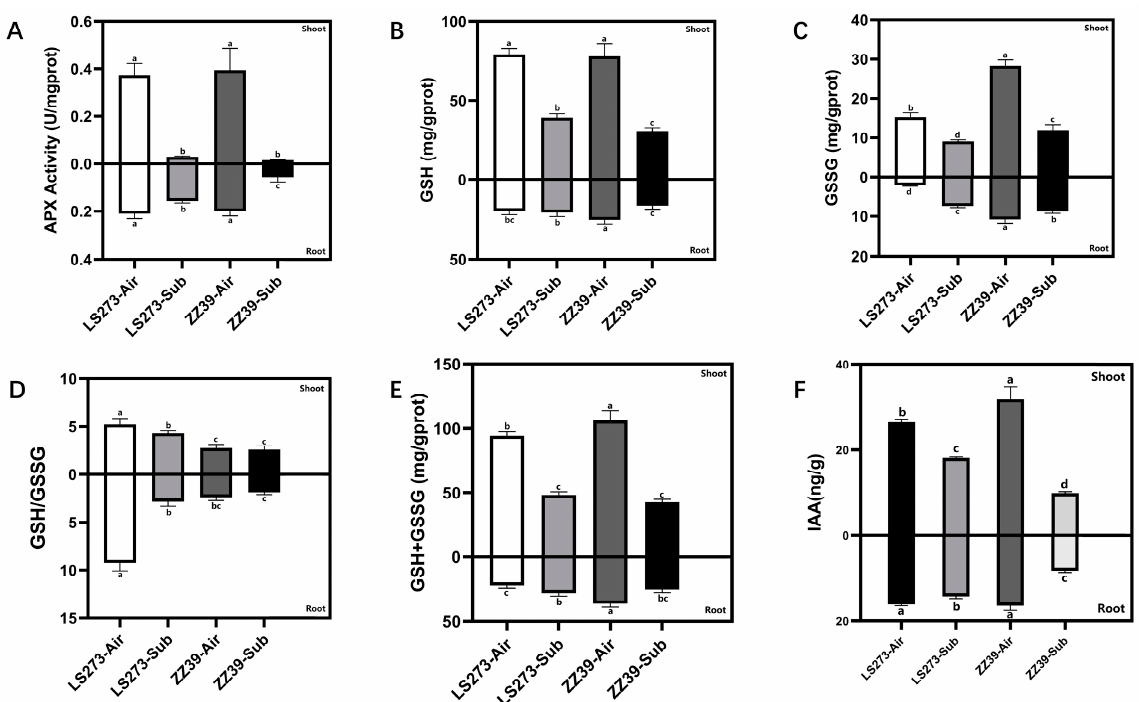
Figure 3. Glutathione cycle and growth hormone measurement. ( A ) APX activity; ( B ) GSH content; ( C ) GSSG content; ( D ) GSH/GSSG; ( E ) GSH + GSSG content; ( F ) IAA content. Columns with the same letter are not significantly different at p < 0.05, one-way ANOVA, followed by Tukey’s honest significant difference tests.